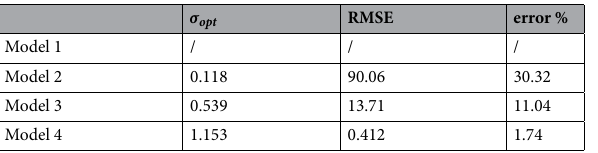
Table 1. Results of the optimization of σ on the root-mean-square error (RMSE) between the predicted thresholds and the thresholds from the experiment for the 4 models. The error is also expressed as the percentage error for visualization. Optimization with model 1 is not possible.